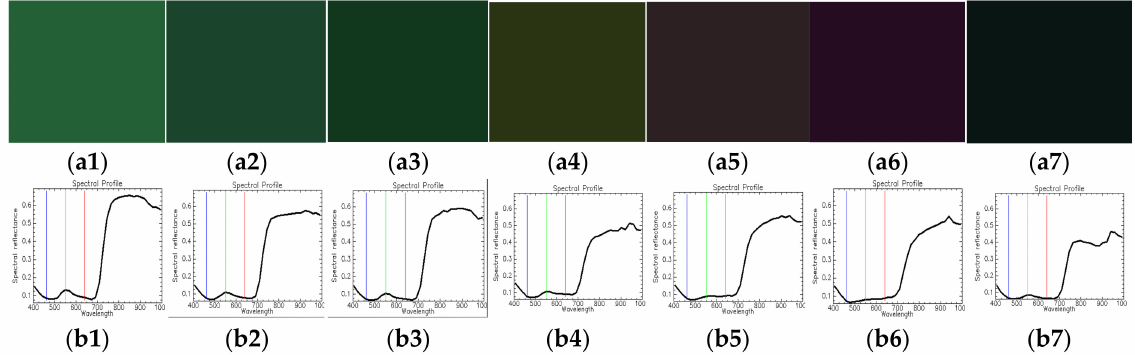
Figure 4. ( a1 – a7 ) refers to the pixel display diagram in which several typical pixels are randomly selected and combined with red light, green light, and blue light. ( b1 – b7 ) are corresponding spectral curves (the red, green, and blue lines in figures ( b1 – b7 ) represent the positions of red light, green light, and blue light, respectively). The typical pixel spectrum after image classification is shown as an example. With the deepening of the pixel RGB map ( a1 – a7 ), the spectral curve has a visible decline in the near-infrared region ( b1 – b7 ), indicating that the mixed pixels are seriously affected by the